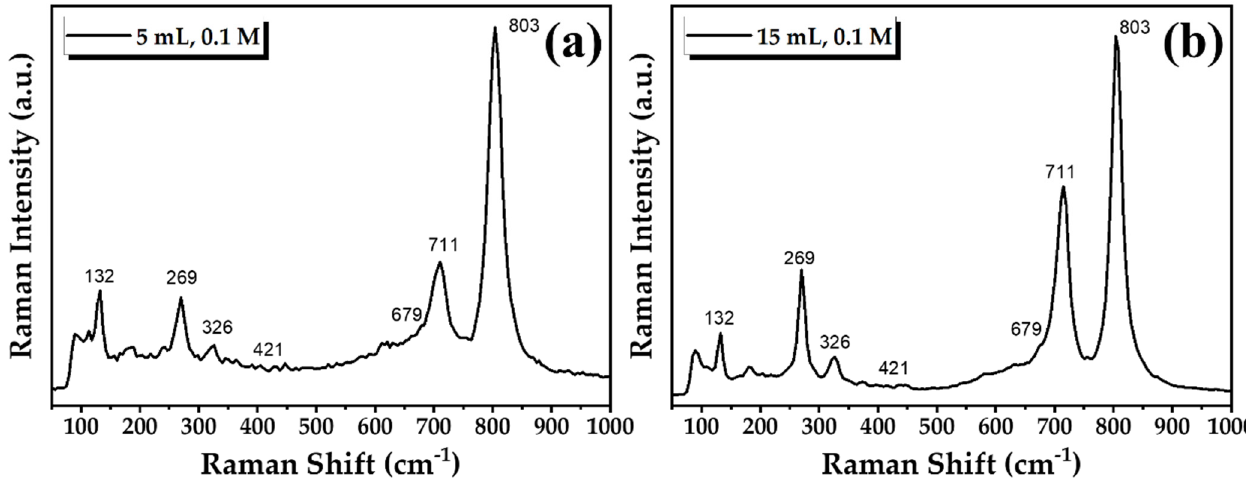
Figure 8. Typical Raman spectra of WO 3 thin films studied in this